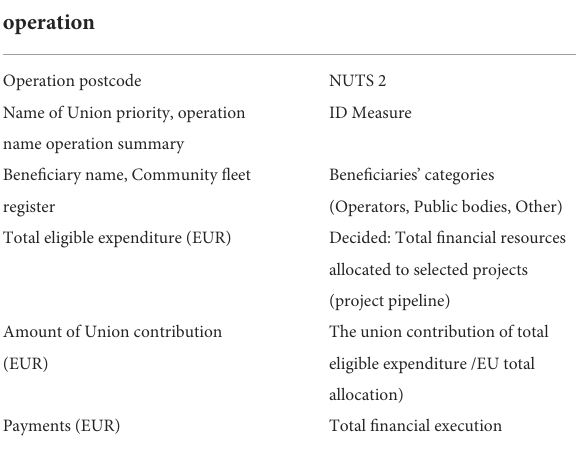
TABLE 2 EMFF measures that may have an impact on the environment based on the subsidy